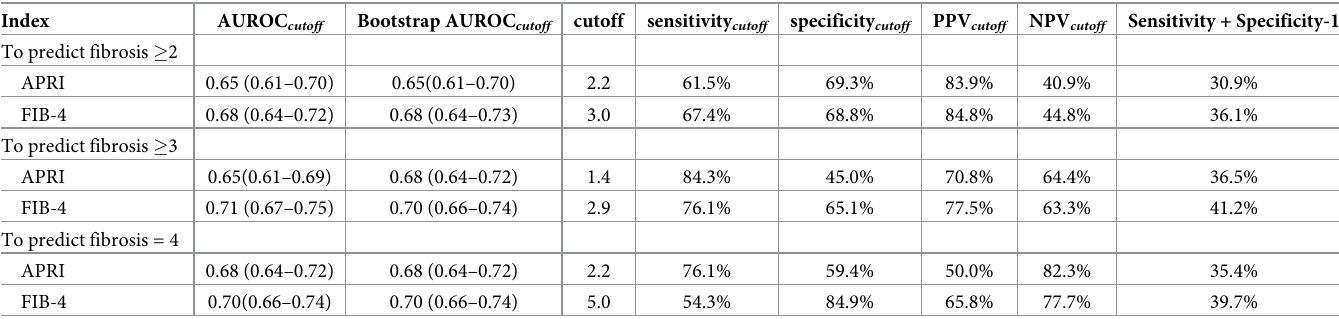
Table 8. Diagnostic accuracies of APRI and FIB-4 for predicting liver fibrosis (Moderate to severe necroinflammation score 9–18, N = 540). Index AUROC